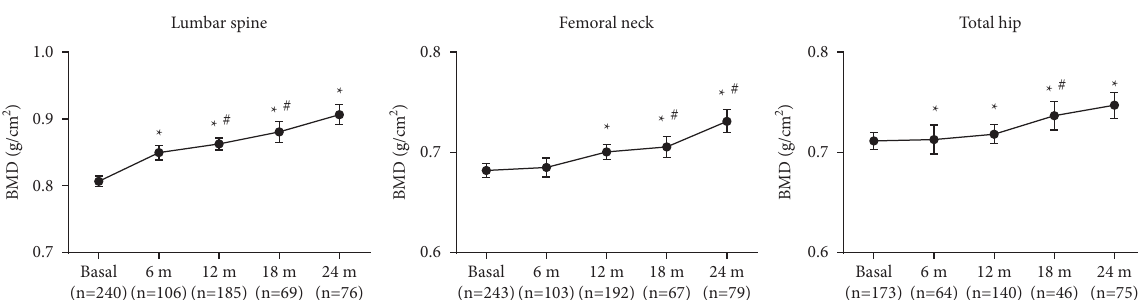
Basal 6 m 12 m 18 m 24 m (n=240) (n=106) (n=185) (n=69) (n=76) Figure 1: Changes in bone mineral density during treatment with teriparatide. Wilcoxon signed-rank test. Mean ± SEM. ∗ Indicates signifcant diferences vs. basal ( p < 0 . 05). # Indicates signifcant diferences vs. previous ( p < 0 . 05).